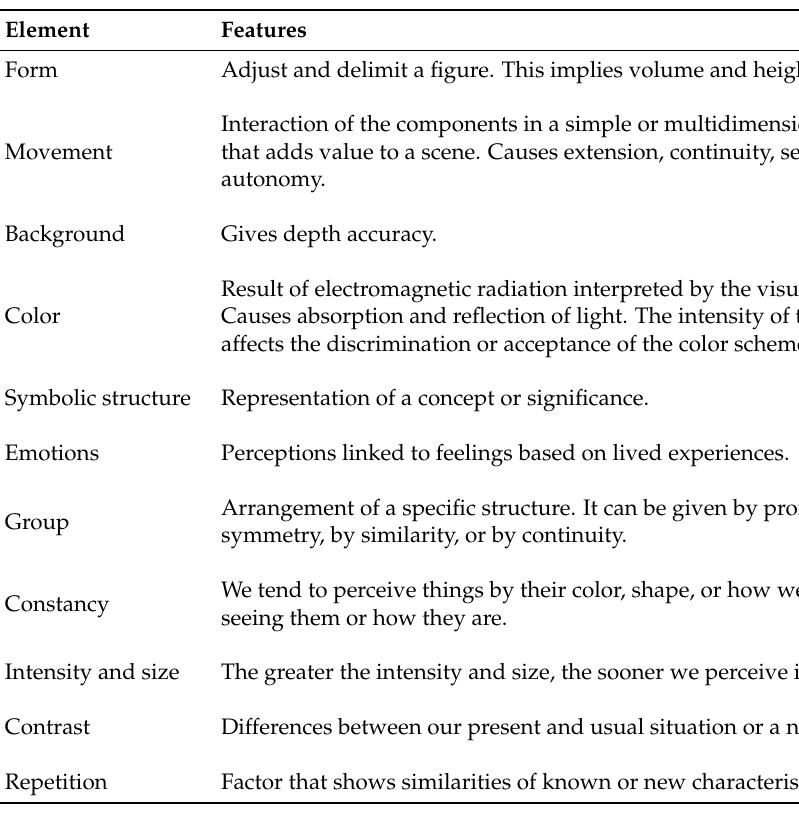
Table 3. Elements of the